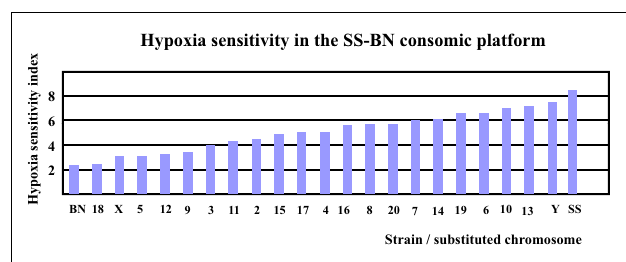
Hypoxia sensitivity in the SS-BN consomic platform